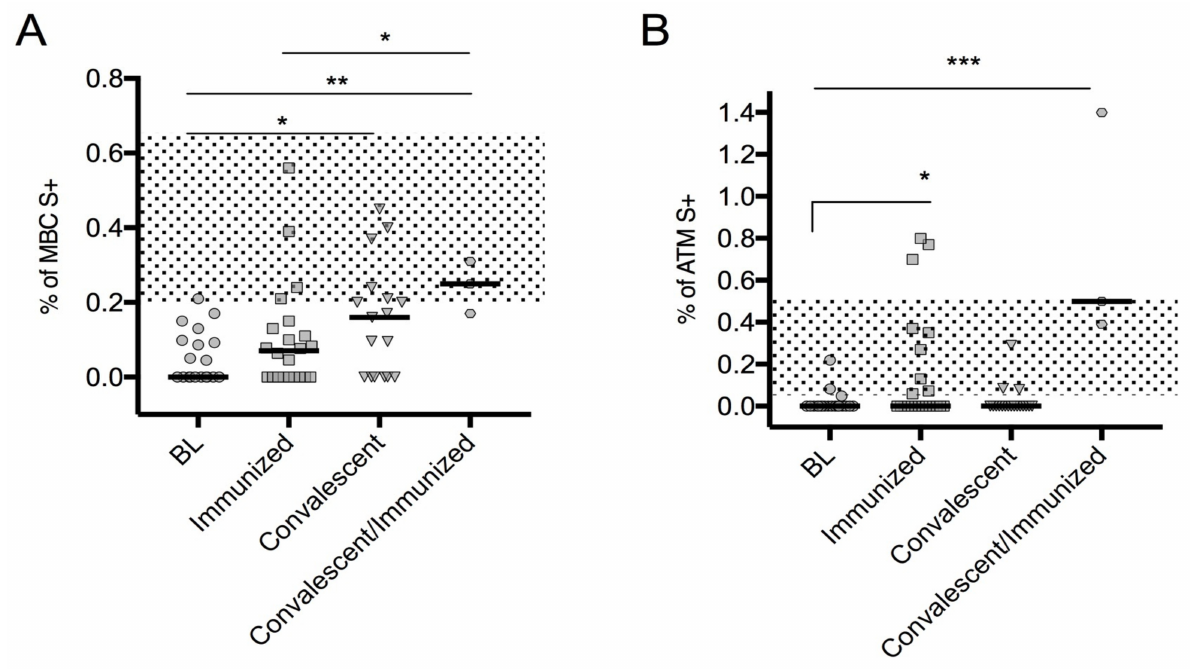
Figure 2. Spike-specific MBC subsets in the CVID cohort. Spike-specific MBCs ( A ) and ATMs ( B ) data are shown at BL (n = 23), after immunization (immunized, n = 23), after SARS-CoV-2 infection (convalescent, n = 17), and after immunization in SARS-CoV-2 convalescents (convalescent/immunized, n = 3). Medians are plotted as horizontal bars. The dotted area represents the IQR range in HD after immunization as previously reported [26]. Levels of significance were measured by two-tailed Mann–Whitney U-test and for Wilcoxon matched-pairs signed-rank test (comparison between convalescents and convalescents/immunized only): *** p < 0.001; ** p < 0.01; * p < 0.05. Abbreviations: BL, baseline; MBC S+, spike-specific memory B cells; ATM S+, atypical memory B